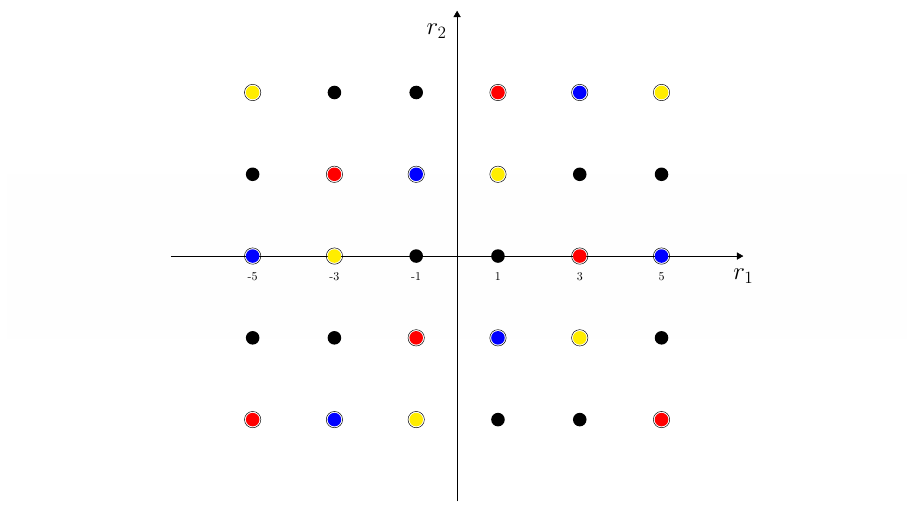
Figure 7 . The r lattice of resolved C 3 = Z